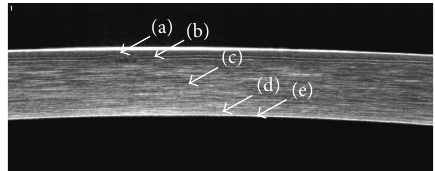
Figure 1: Horizontal OCT section of the normal cornea: epithelium (a), Bowman’s layer (b), corneal stroma layer (c), Descemet’s mem- brane (d), and endothelium